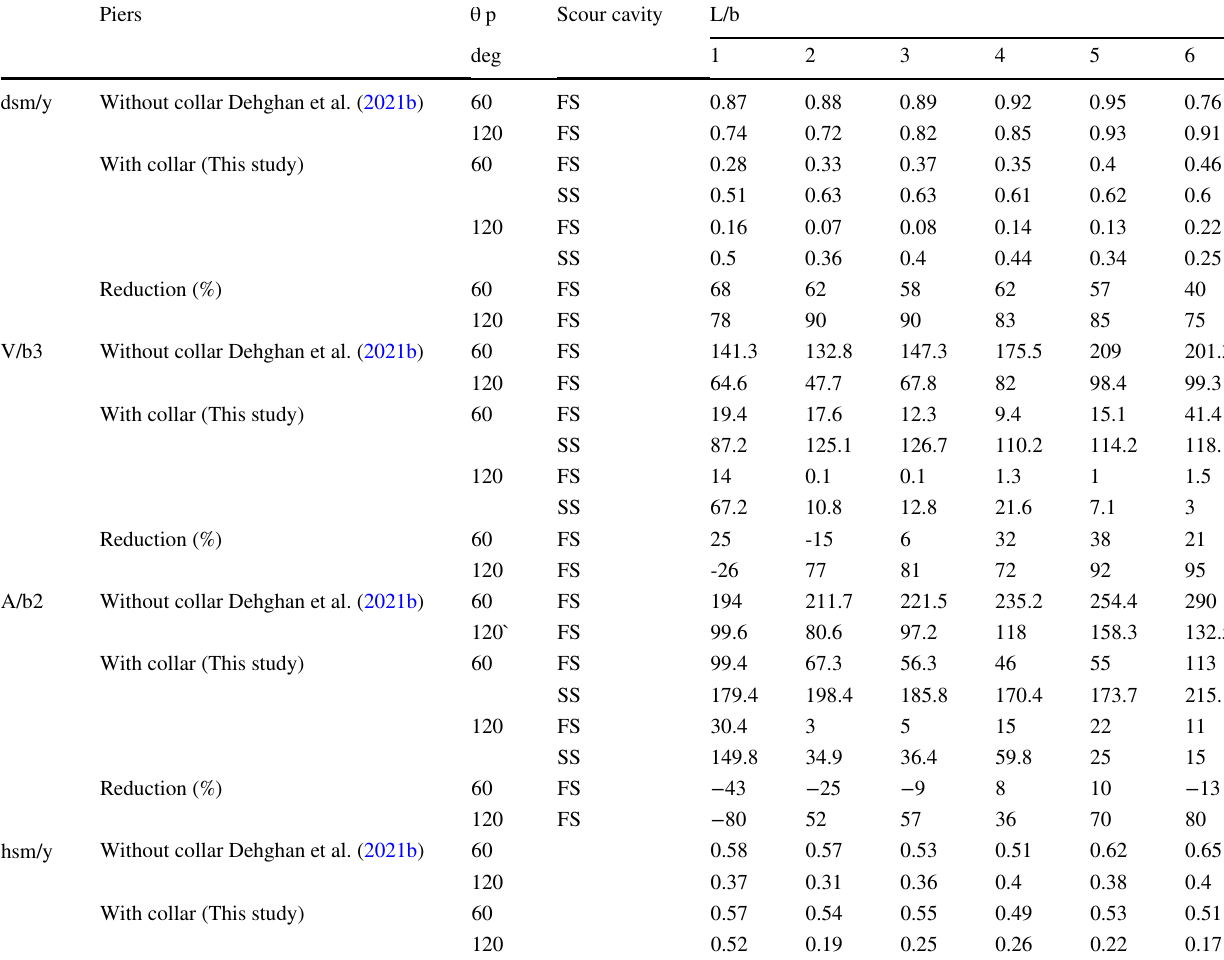
Table 1 Experimental data surrounding the combination of piers and collar of W/b = 4 installed at the 60- and 120-degree positions Piers θ p Scour cavity L/b